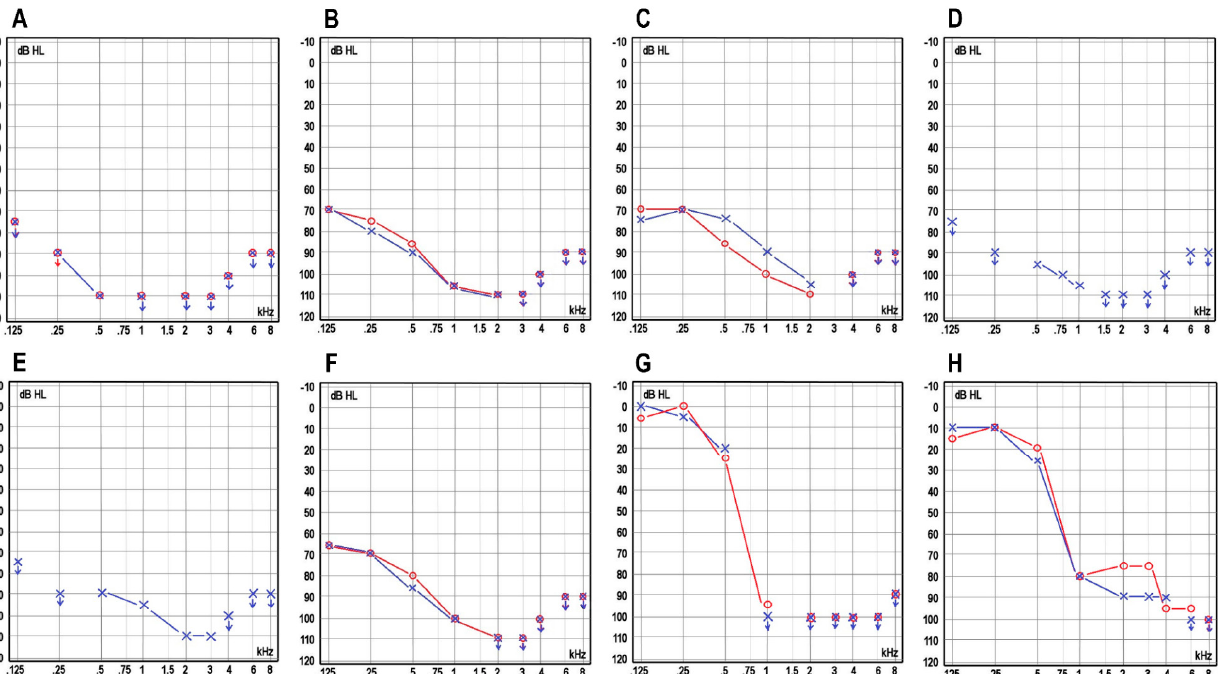
Figure 2. Pure tone audiograms (PTA) of the affected individuals. ( A ) Patient 1, ( B ) Patient 3, ( C ) Patient 5, ( D ) Patient 6, ( E ) Patient 7, and ( F ) Patient 8. All six of these patients showed severe-to-profound sensorineural hearing loss and mildly down-sloping curves associated with recessive pathogenic TMC1 variants. ( G ) Patient 10 and ( H ) Patient 11 had deeply down-sloping curves, demonstrating predominant deterioration of higher frequencies associated with a dominant pathogenic TMC1 variant. In all patients, the last available audiograms are shown. Patients 3, 5, and 11 have not received CIs. In Patients 1, 6, and 7, the audiograms shown are after the first, but before the second CI operation. In Patient 8 the audiogram shown is after bilateral CI operations. In Patient 10, the audiogram shown is before the CI operation. The red circles indicate the right ear and the blue X’s indicate the left ear.